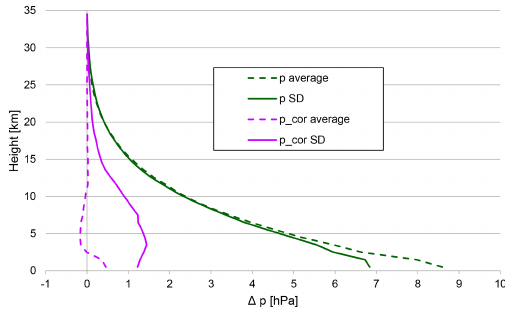
Figure 22. The average pressure difference ( (cid:49)p = p ascent − p descent ) and its standard deviation (SD) before and after applying temperature correction for friction and pressure